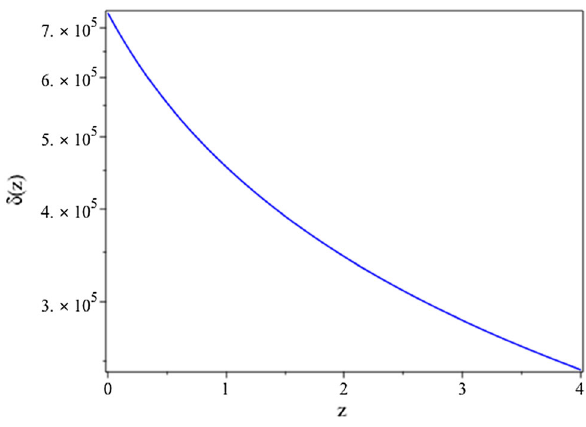
Fig. 2 The growth of the density contrast for Eq. (125) (GR